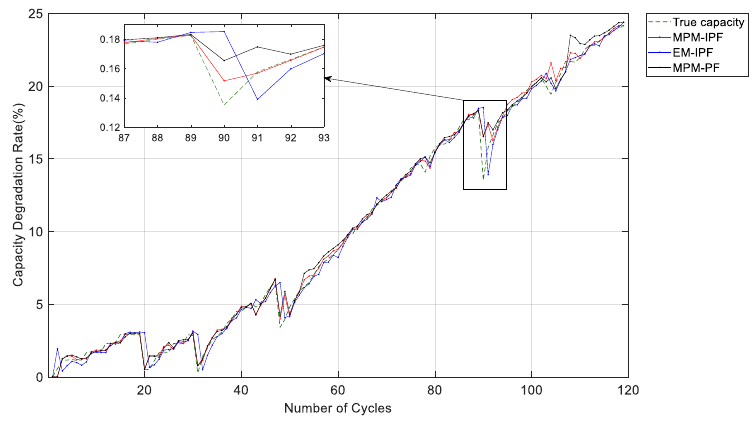
Figure 9. Comparison chart of No. 5 battery capacity prediction.